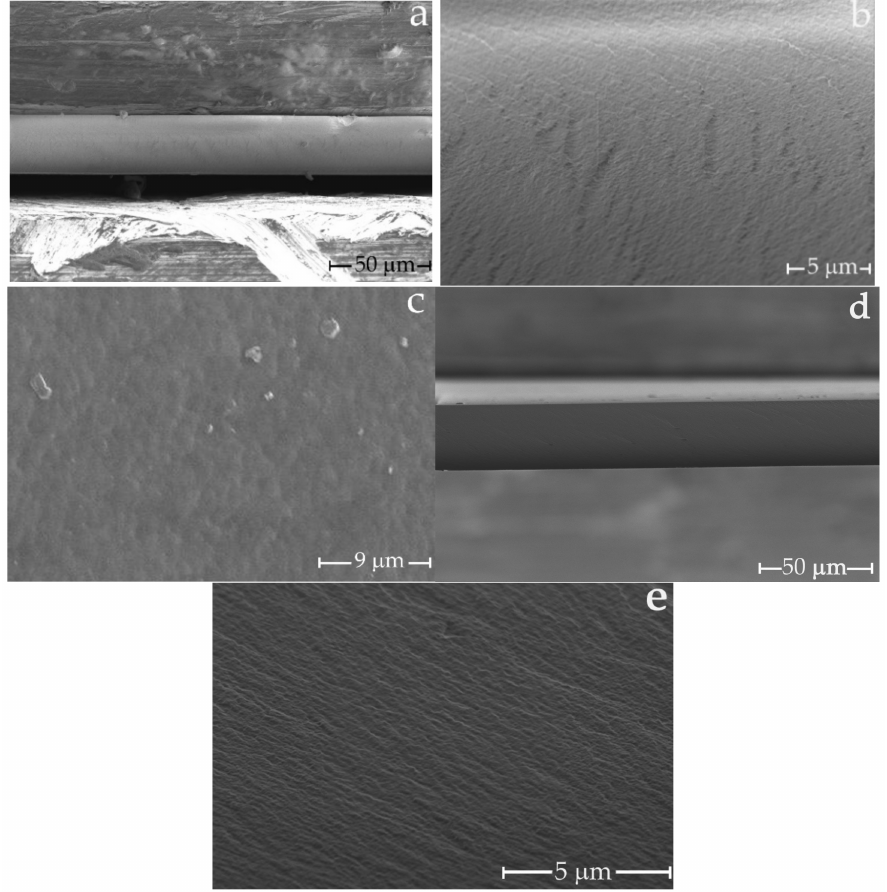
Figure 3. SEM microphotographs of LF-1 and C-1 films: ( a , b ) are cross-sections of LF-1, ( c ) is surface layer of LF-1, ( d , e ) are cross-sections of